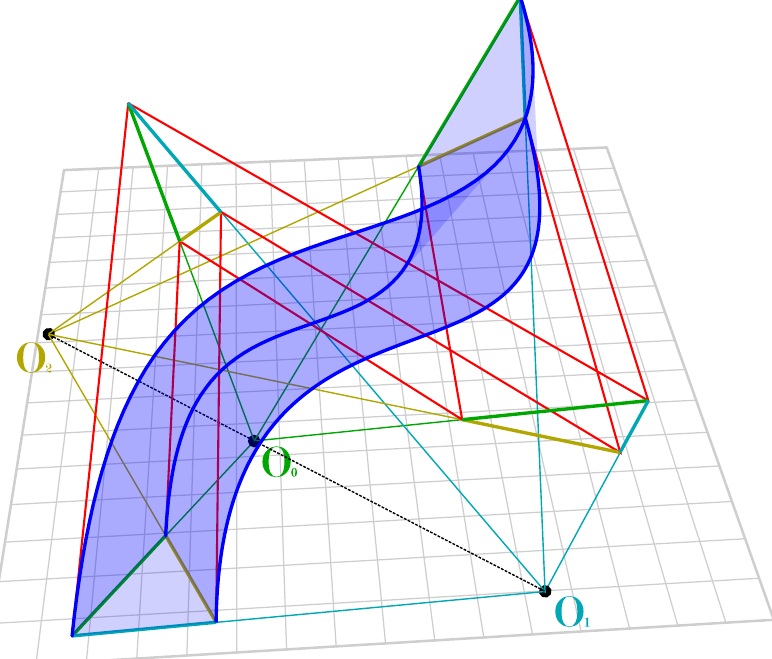
Figure 8. Three developable ruled surfaces between three homothetic spline curves.